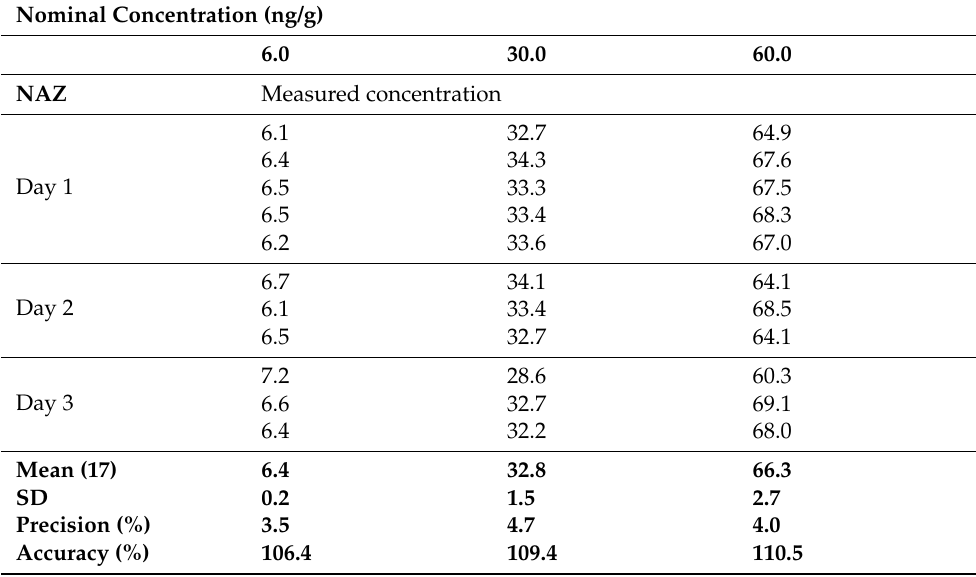
Table 6. Interday precision and accuracy for NAZ in brain tissue.